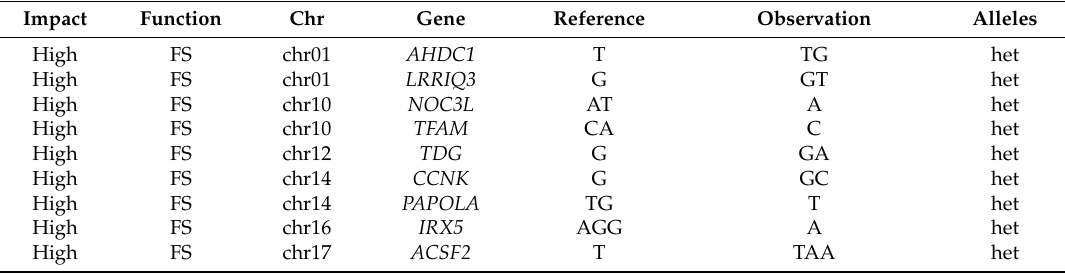
Table 3. Impact and functional annotations of detected Indel variations.